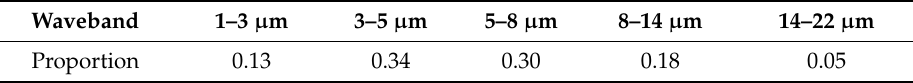
Figure 5. Radiation ability of blackbody and graybody at 773 K. Table 3. Proportion of each waveband for blackbody at 773 K.